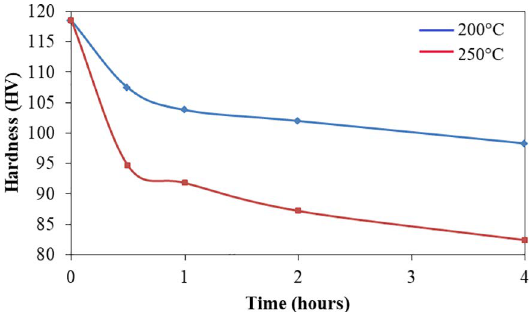
Figure 8. Softening behavior of samples annealed at 200°C and 250°C.